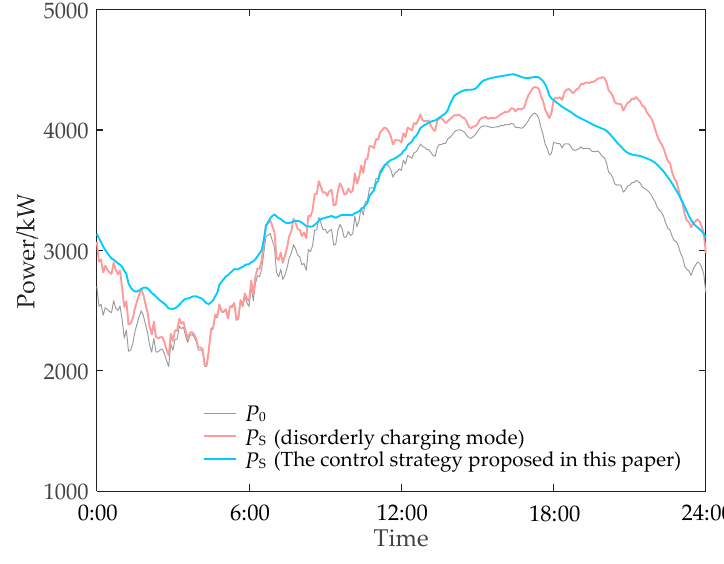
Figure 8. Total load curve.